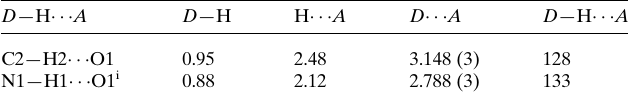
Table 1 Hydrogen-bond geometry (A˚ , (cid:2) ).